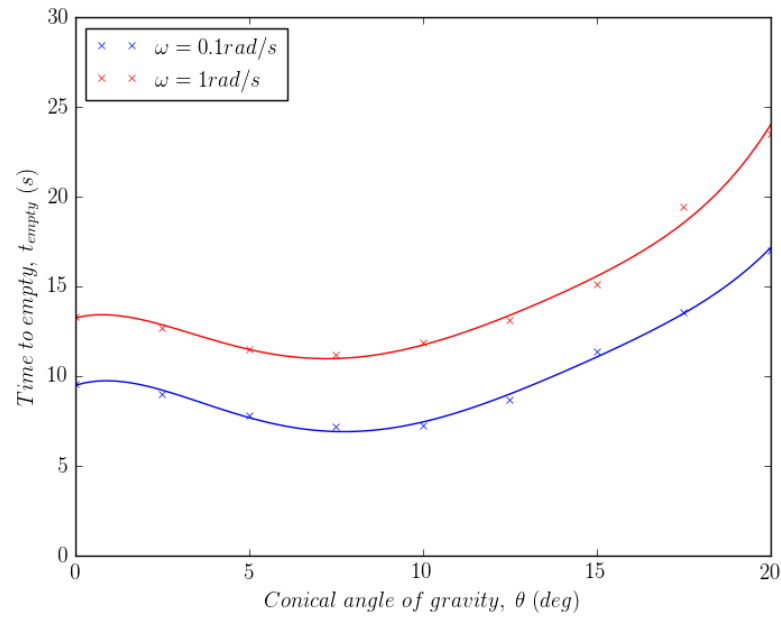
Figure 14. Time to empty versus angle of gravity vector.